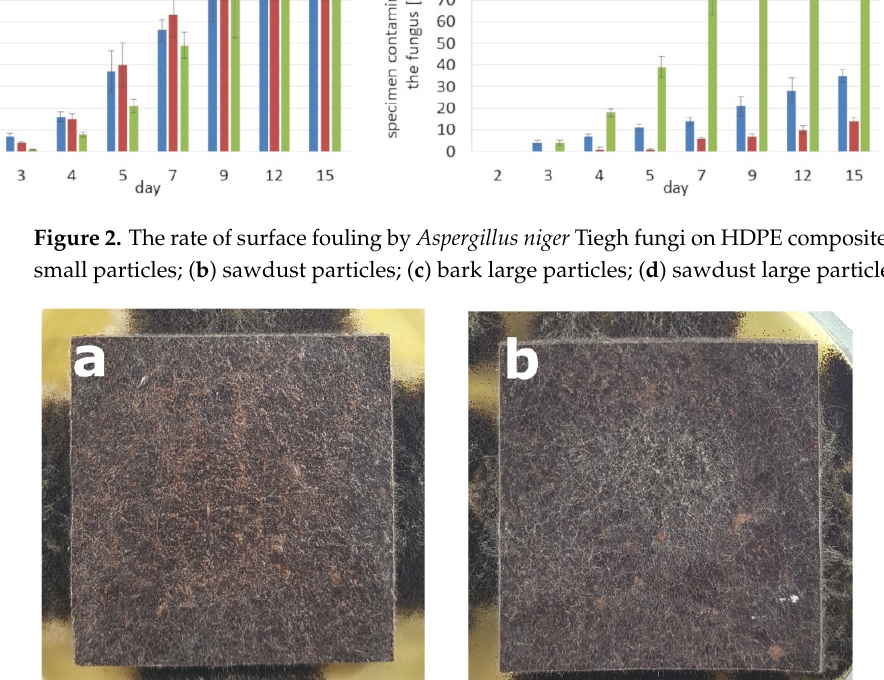
Figure 3. Example of mold growth ( Aspergillus niger Tiegh) after 7 days of exposure of composite samples with large particle bark filler of 60%, based on a matrix: ( a ) HDPE; ( b ) PLA.